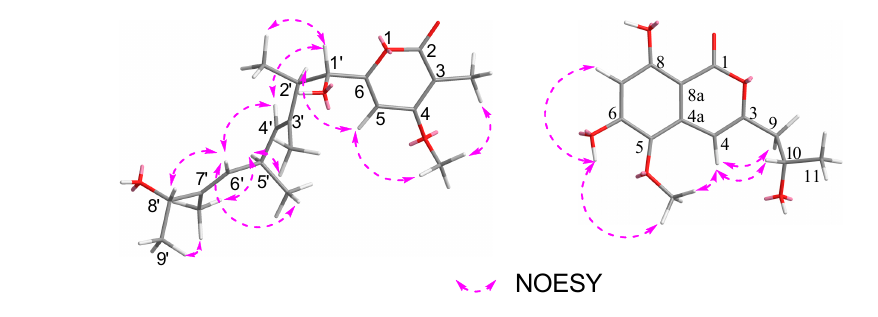
Molecules 2020 , 25 , x FOR PEER REVIEW Figure 3. Key NOESY correlations of 1 and 2. Figure 3. Key NOESY correlations of 1 and 2. Figure 3. Key NOESY correlations of 1 and 2.